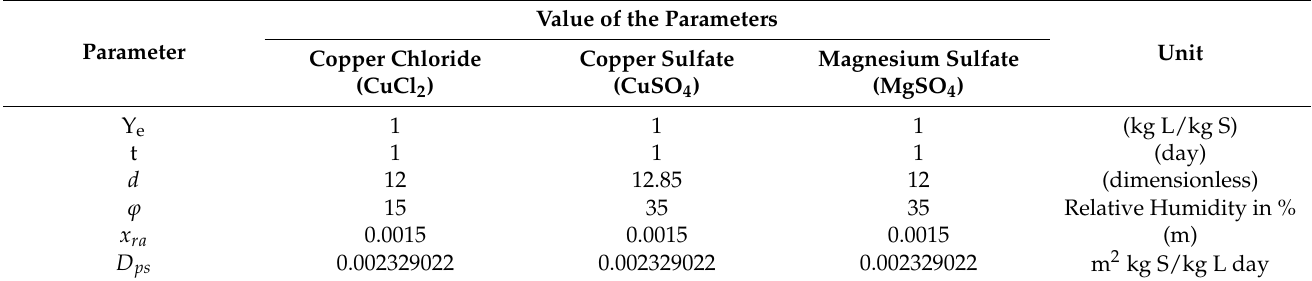
Table 2. The initial data on the dynamic RH for the current model.